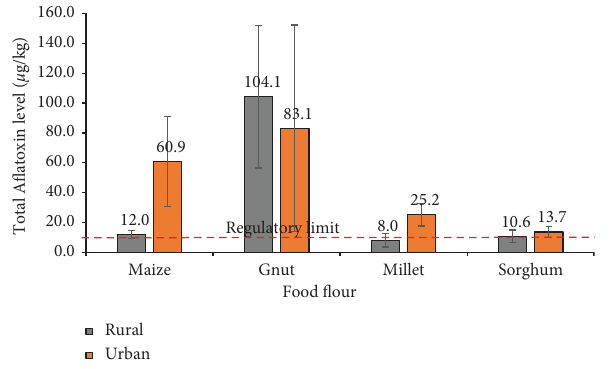
Figure 5: Afatoxin levels (mean ± SEM) in foods from rural versus urban areas (the regulatory limit for E. Africa is in broken